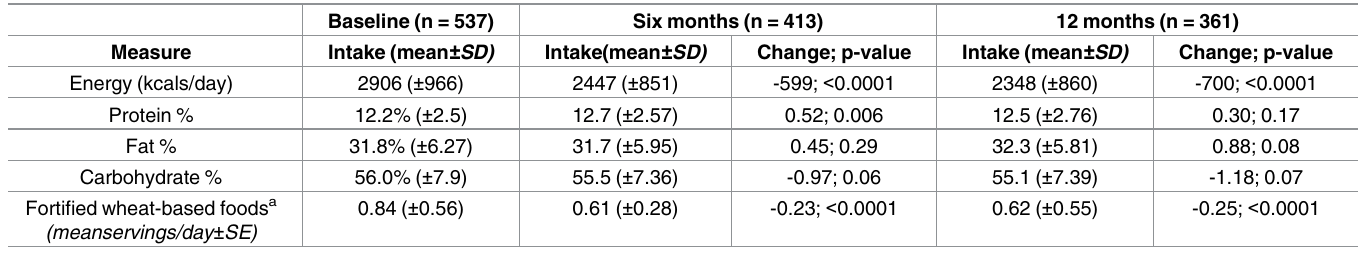
Table 3. Macronutrient and fortified wheat flour intake among non-pregnant women of reproductive age in Dar es Salaam, Tanzania. Baseline (n = 537)